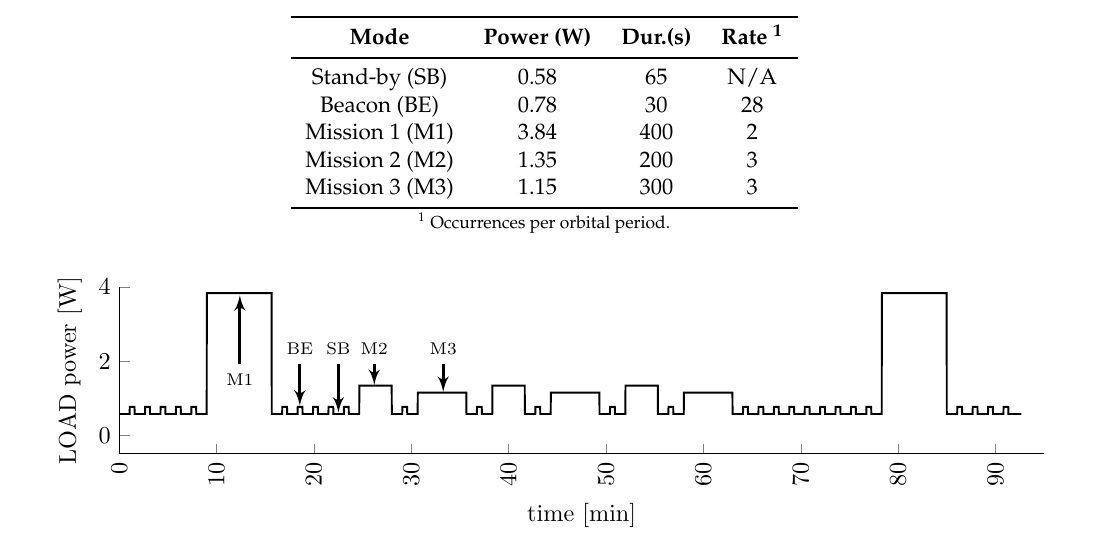
Figure 8. Load profile over an orbital